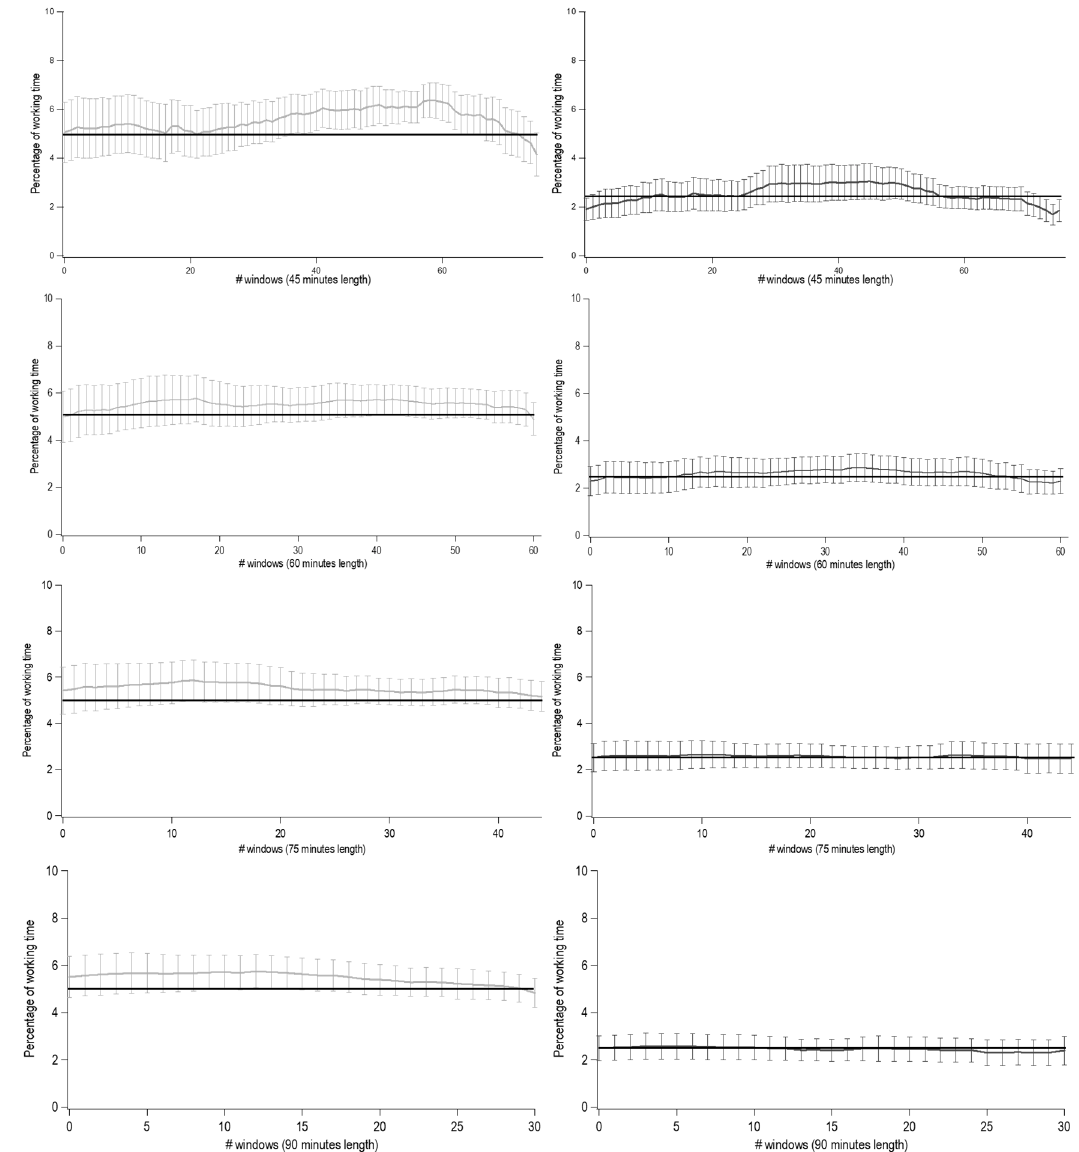
Figure A1. Mean values of the percentage of time spent in two classes of trunk flexion. Each point represents the mean value (standard error) calculated across the workers using windows of different duration, from 15 (top) to 90 (bottom) minutes, using steps of 1 min. Black lines represent the “True” value calculated as mean exposure obtained from the entire 2 h of monitoring.